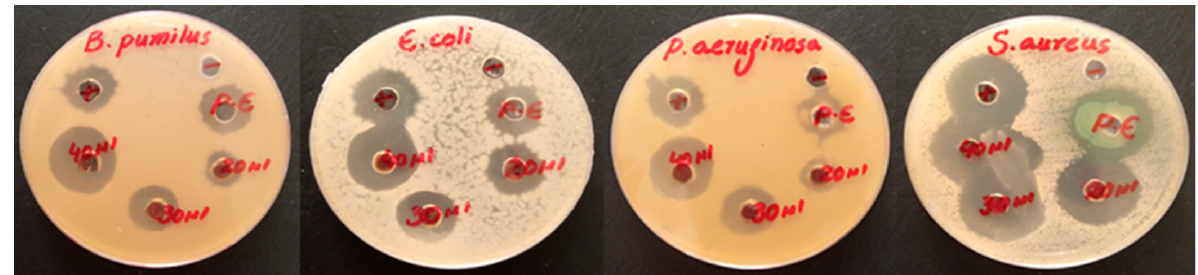
Figure 7. Antibacterial activity of plant-based Fe 3 O 4 NPs against gram-positive and gram-negative bacteria.